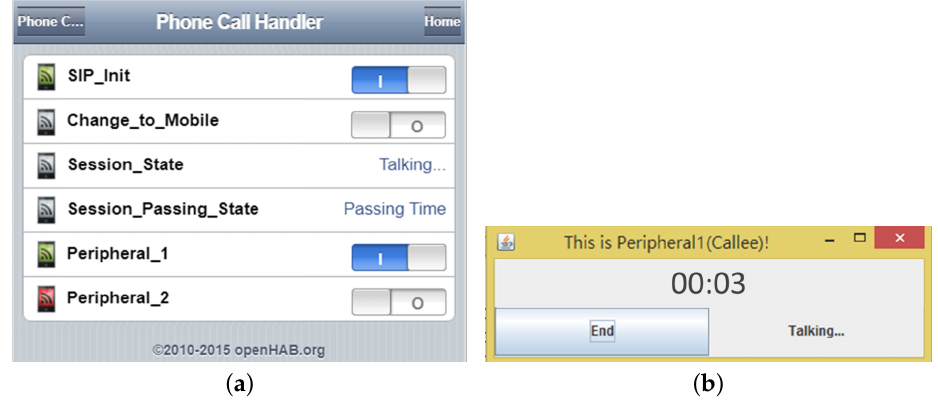
Figure 10. Application program for ( a ) the personal self IMS to session changes on the IMS proxy platform; and ( b ) peripheral